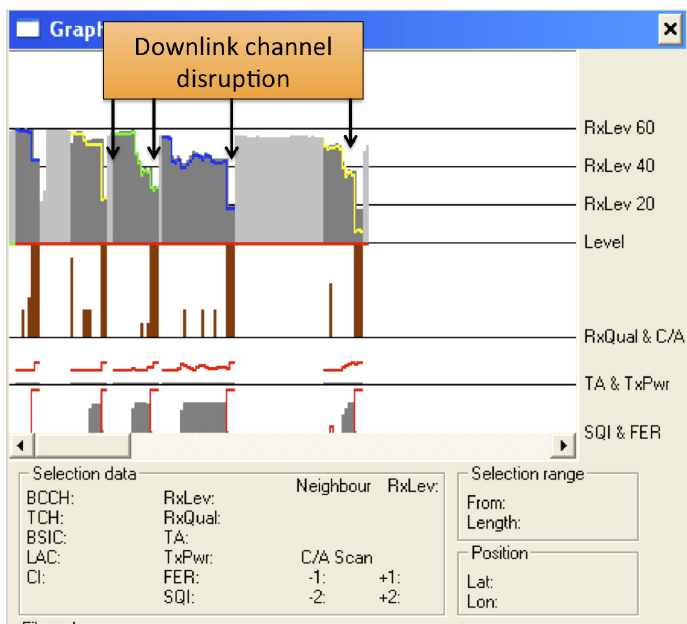
Figure 12. Downlink loss and cell